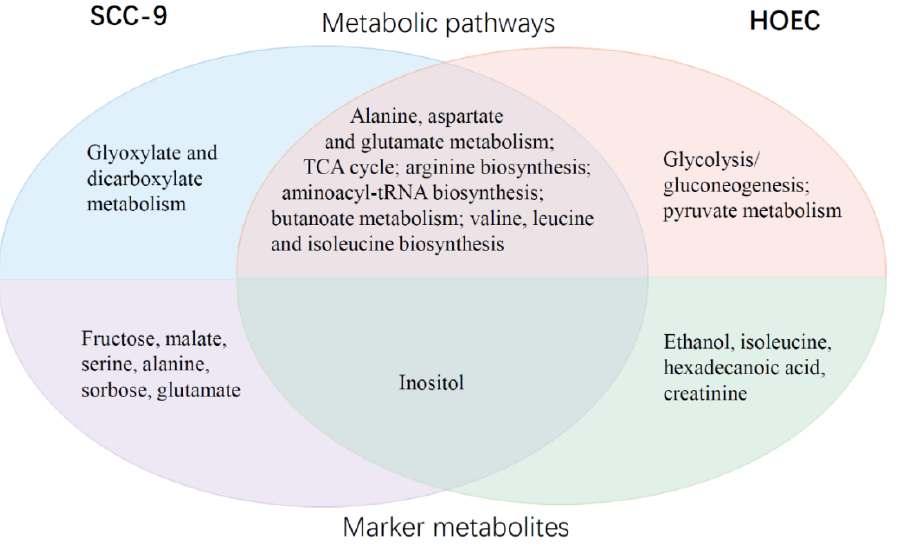
Figure 9 . Comparisons of enriched metabolic pathways and marker metabolites of SCC-9 and HOEC cells in response to cisplatin stimulation.